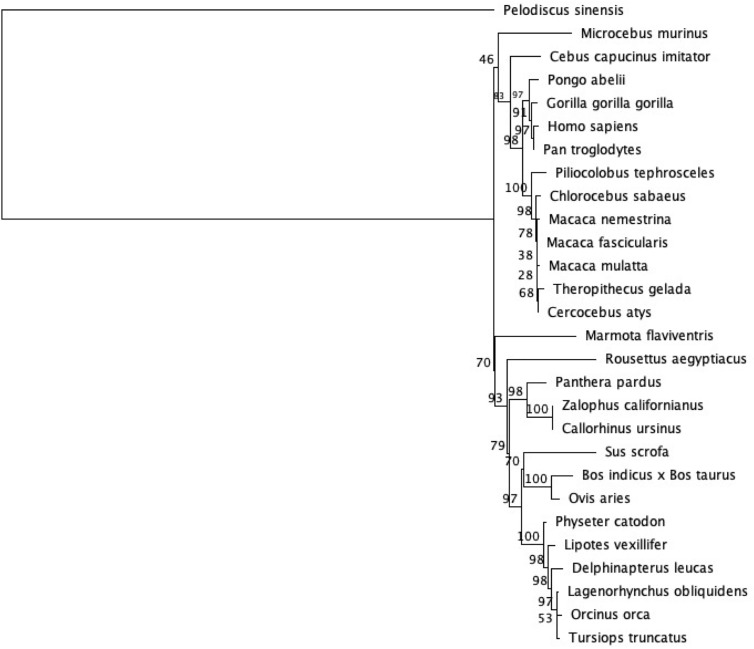
Maximum likelihood phylogenetic analysis of mammalian BHLHE41 coding sequence.We used the GTR+CAT+I parameter settings with 100 bootstrap replicates which are indicated next to the branches. The tree is rooted with the reptilian outgroup, Pelodiscus sinensis.